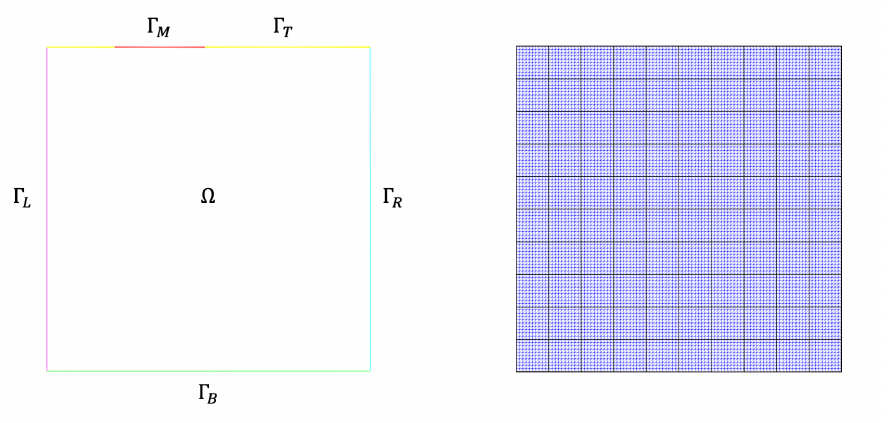
Figure 7. Computational domain and grids (from left to right). The fine grid is blue, the coarse grid is black.